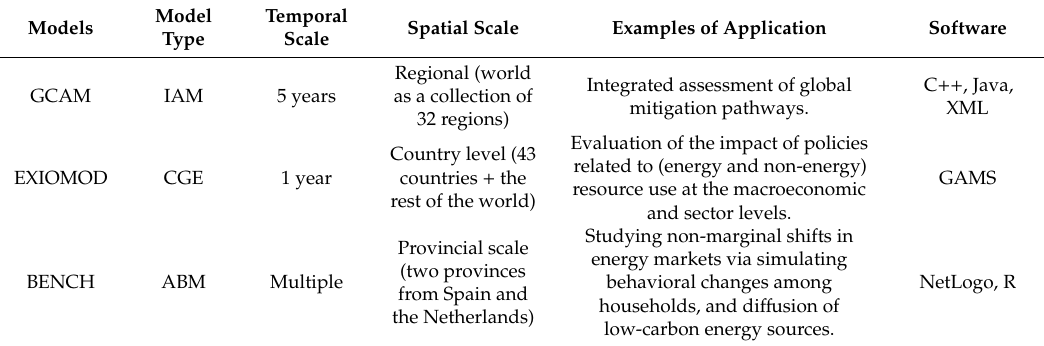
Table 1. Brief summary of the three models selected for